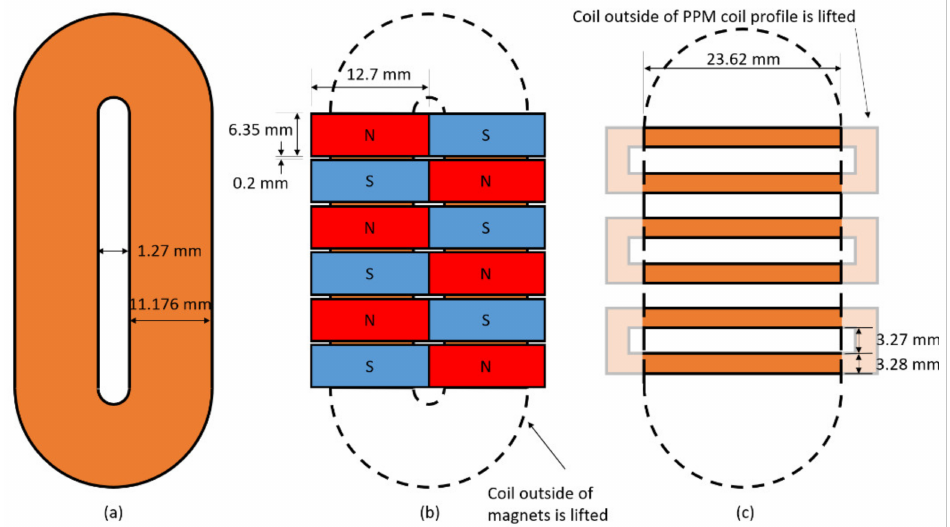
Figure 8. Overhead View and Dimensions of each EMAT Configuration. ( a ) Racetrack coil (PPM with Magnets Removed); ( b ) PPM EMAT; ( c ) Meander coil in the MS-EMAT transmitter. “Lifted” portions of coils are sufficiently distant from the test plate that they do not participate in the transduction mechanism.